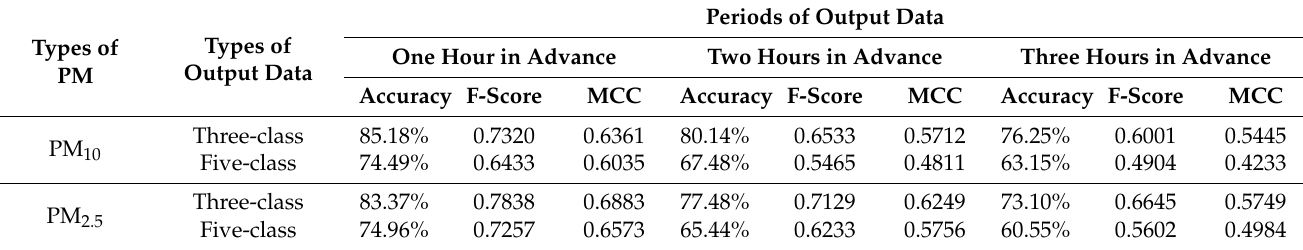
Table 8. Implementation results to predict both types of PM with additional